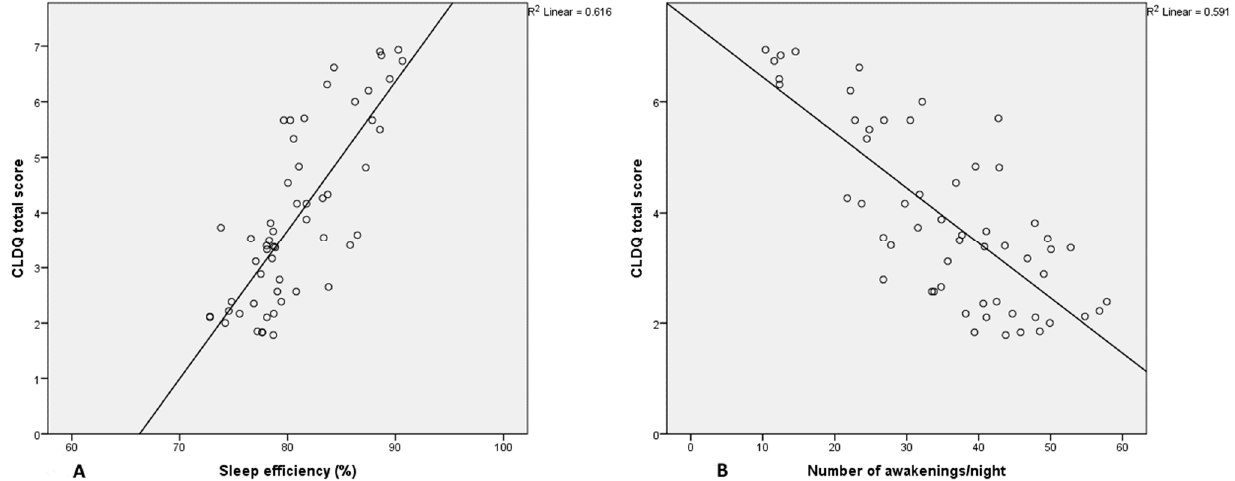
Figure 2. Scatter Plot representing the relationship between sleep efficacy ( A ) and number of awakenings per night ( B ) and CLDQ scores. Abbreviations: CLDQ = chronic liver disease questionnaire.